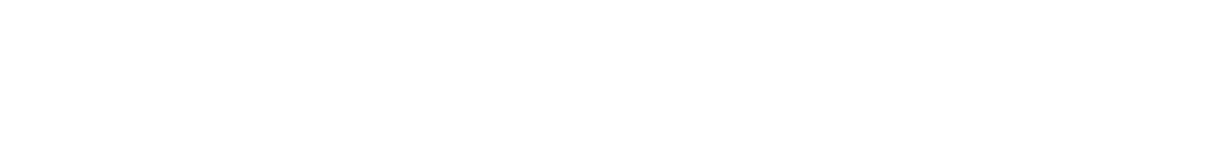
Frontiers in Materials |